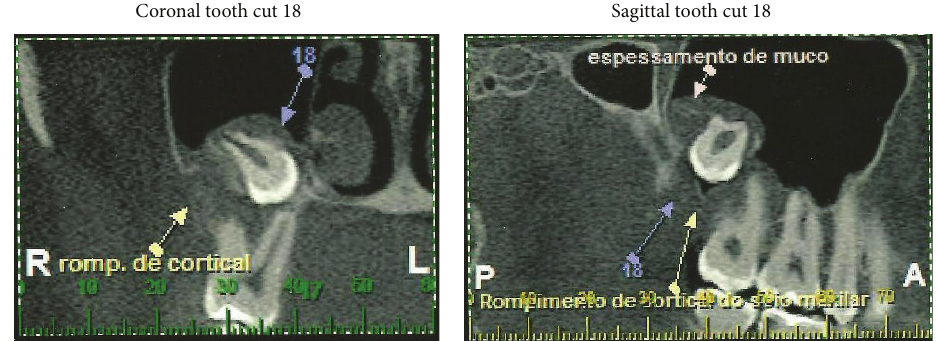
Figure 3: Computed tomography examination of the maxilla by volumetric acquisition to better locate DU 18.